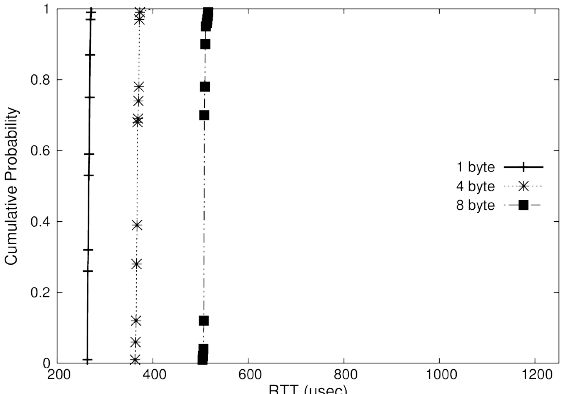
Figure 8. Cumulative Distribution Function (CDF) of RTT in a non-virtualized case.